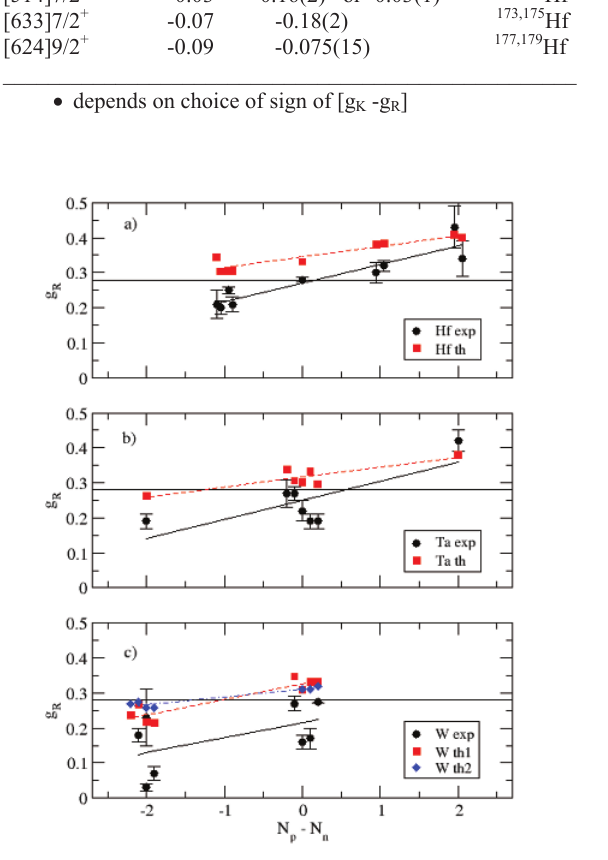
Figure 2 g obtained in this work as a function of the R number of qps N , N , in comparison with model p n calculations [4], [11], [12]. Comparison with experimental g values produced by the R present analysis in the same Hf, Ta and W isomers